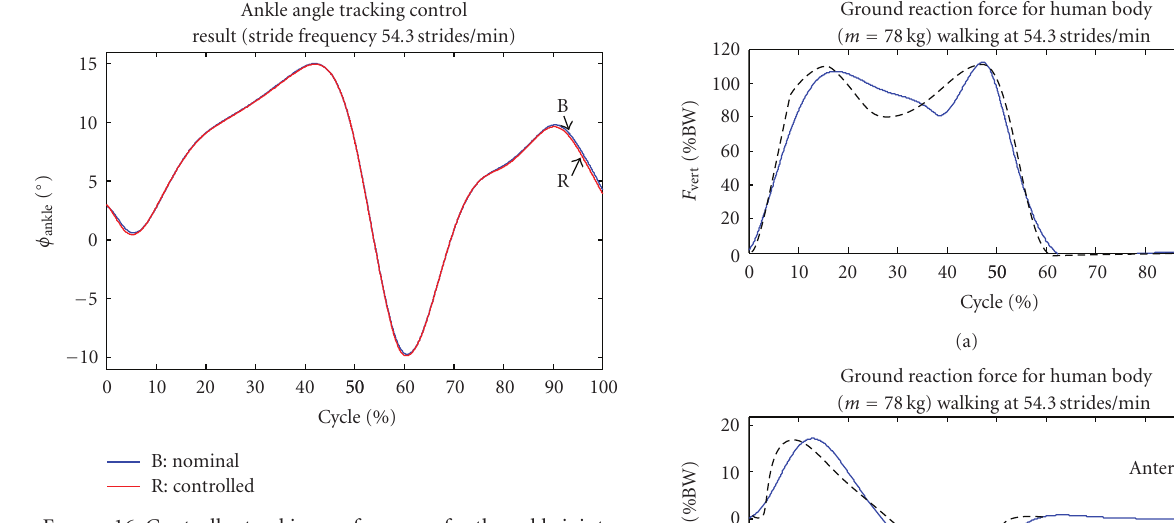
Figure 16: Controller tracking performance for the ankle joint.